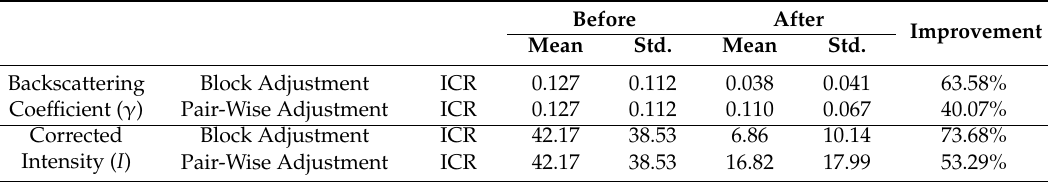
Table 4. Comparison of block and pair-wise adjustments.